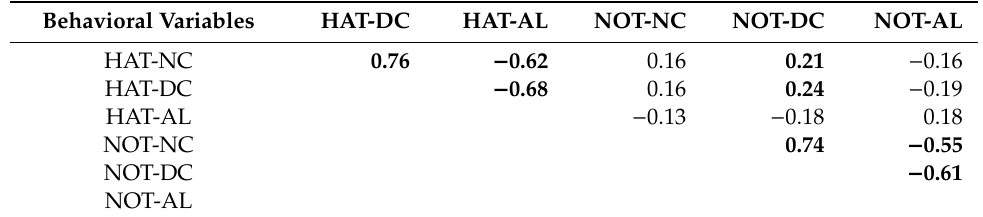
Pearson rank correlations between the residuals of the linear mixed models of the behavioral variables. Behavioral Variables HAT-DC HAT-AL NOT-NC NOT-DC NOT-AL